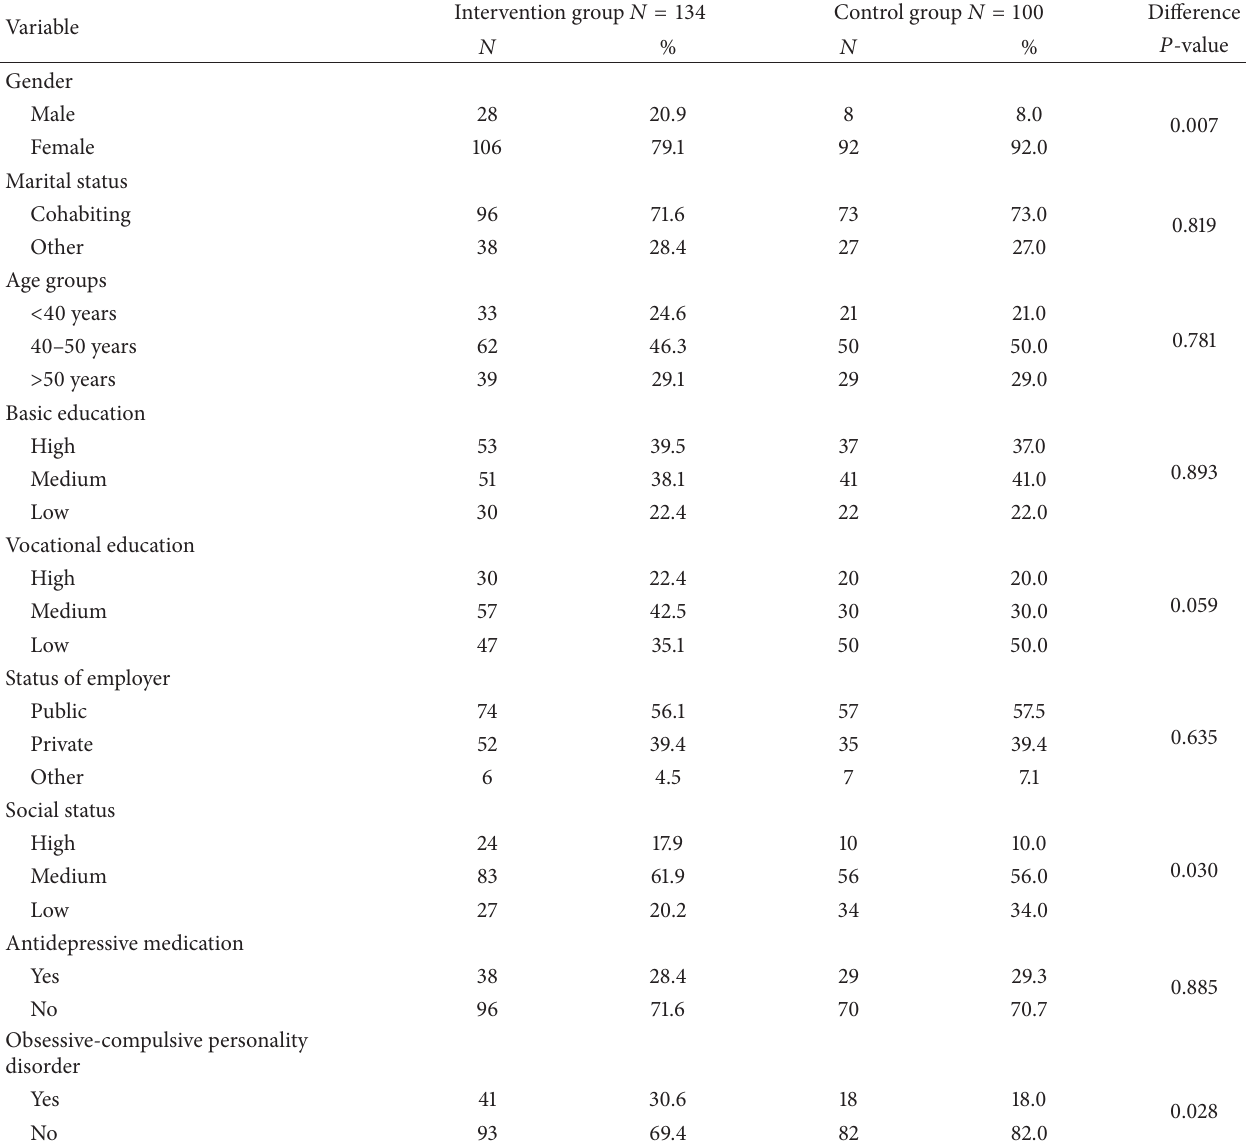
Table 2: Socio-demographic and clinical characteristics of the